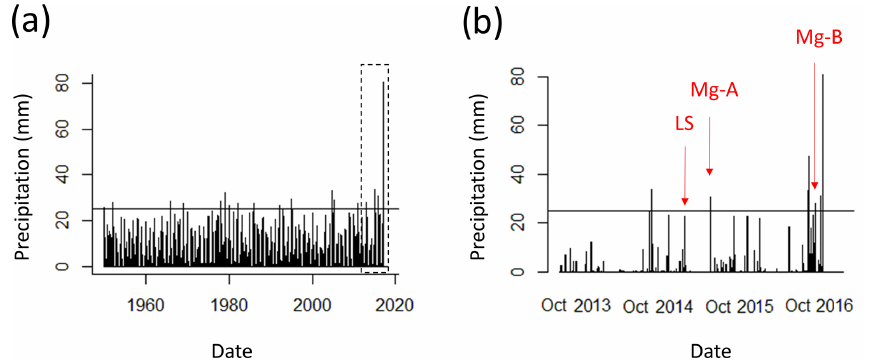
Figure 2. (a) Reconstructed daily rainfall time series measured at the watershed outlet for 1950–2017, with the horizontal line representing the rainfall threshold for rainfall–runoff gullies formation (Gudino-Elizondo et al., 2018a); (b) measured rainfall for water years 2013–2017 and timing of the observed mega-gullies (Mg) and landslide (LS).